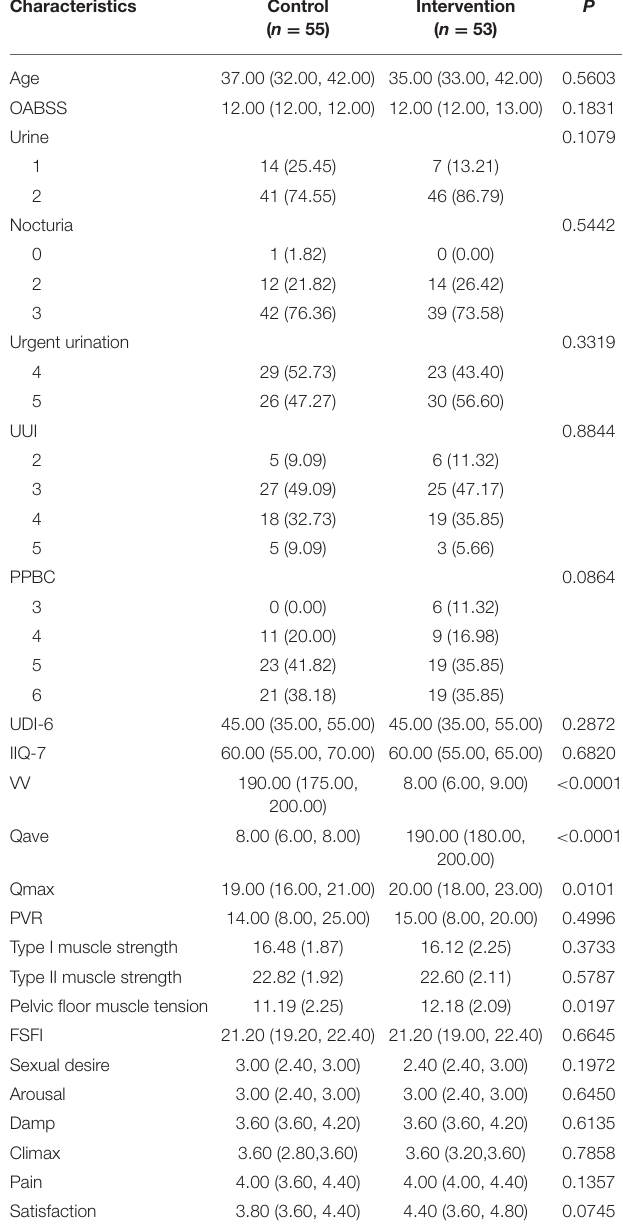
TABLE 1 | The baseline characteristics of patients.